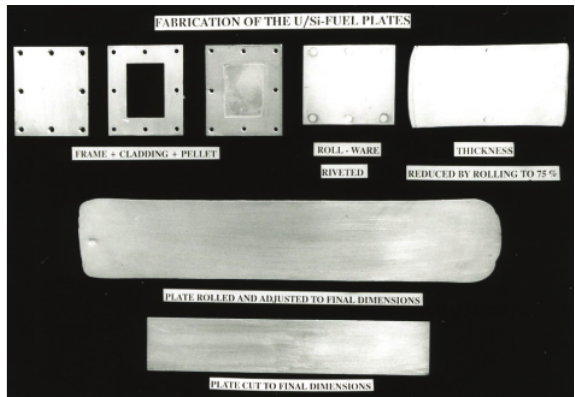
Figure 13: Preparation of the uranium silicide target